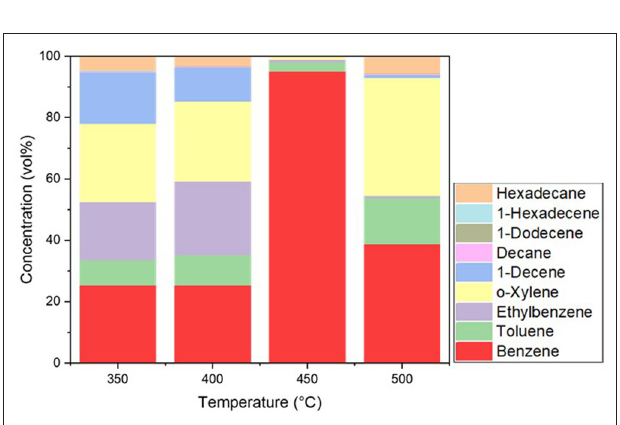
FIGURE 9 | GC-FID analysis of the pretreated ASR pyrolysis oil obtained at 350, 400,450, and 500 ◦ C.